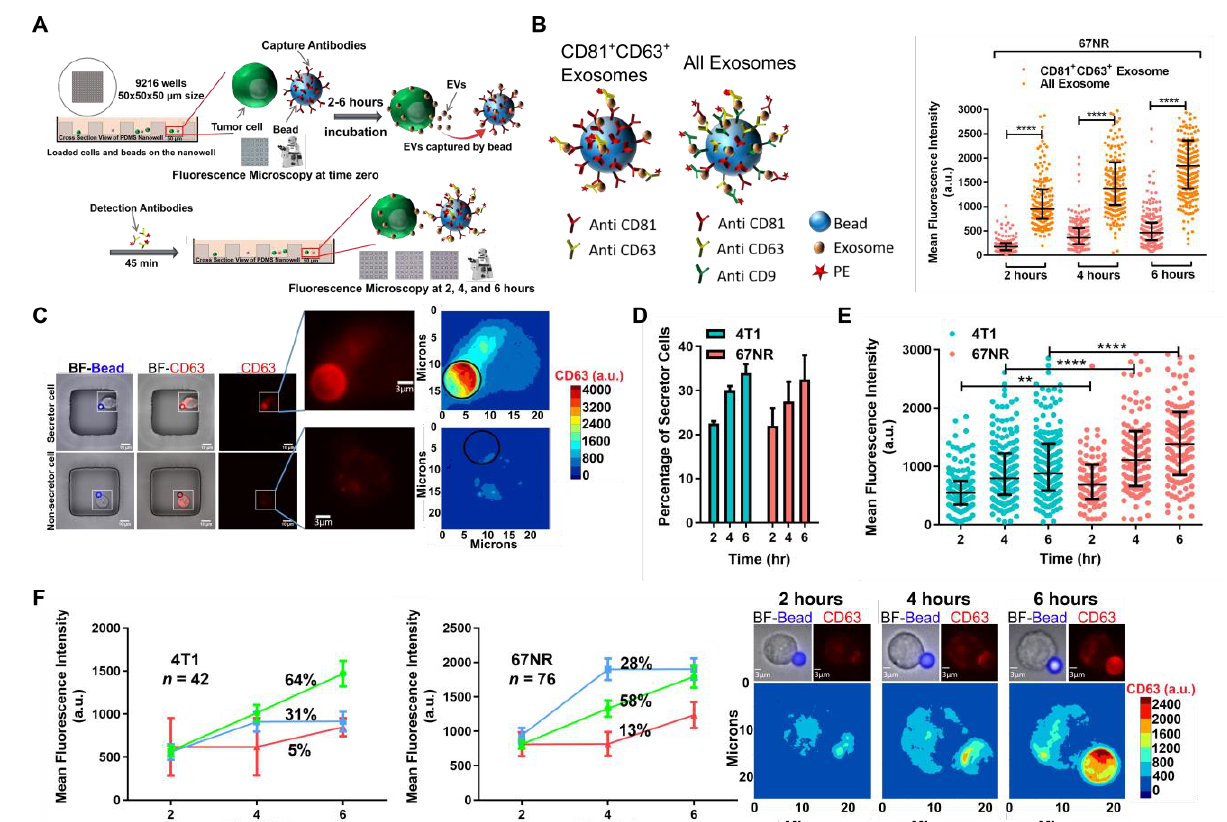
Figure 1. High-throughput single-cell assay for monitoring EV secretion. ( A ) The overall workflow of the single-cell assay. Cells and anti-CD81 conjugated beads are loaded on the nanowell and incubated for 2–6 h. The entire array is incubated with fluorescently labeled antibodies against CD63 and imaged using microscopy. ( B ) Schematic of immunoassays for profiling pan EVs using a cocktail of CD63, CD81, and CD9 antibodies and subset of CD81 + CD63 + EVs using CD81 for capture and CD63 for detection. Each dot represents a single cell with its mean fluorescence which is the intensity of PE anti-CD63 antibody for CD81 + CD63 + EVs or intensity of PE anti-CD63, PE anti-CD81, and PE anti-CD9 antibodies for pan EVs. **** p < 0.00001. ( C ) Representative images of individual nanowells containing 67NR cells with different EV secretion capacities. The insets show single cells and the contour map of CD63 (EVs) intensity. ( D ) Comparison of the frequency of CD81 + CD63 + EVs secreting cells between 67NR (non-metastatic) and 4T1 (metastatic) breast cancer cells (mean ± SEM). ( E ) The rate of secretion of CD81 + CD63 + EVs by 67NR cells is higher than that of 4T1 cells at two, four, and six hours. Each dot represents a single cell with the median and quartiles of CD63 (EVs) intensity shown across all cells. A representative example from three independent repeats is shown. ** p < 0.001 and **** p < 0.00001. ( F ) The kinetics of EV secretion from single cells. The three subpopulations corresponding to (1) continuous secretion (green), (2) secretion initiated at two hours (blue), and (3) delayed secretion at four hours (red) are shown as trend lines (mean ± SEM). Representative images and contour maps of a single cell showing a continuous increase of CD63 intensity on the surface of the bead.